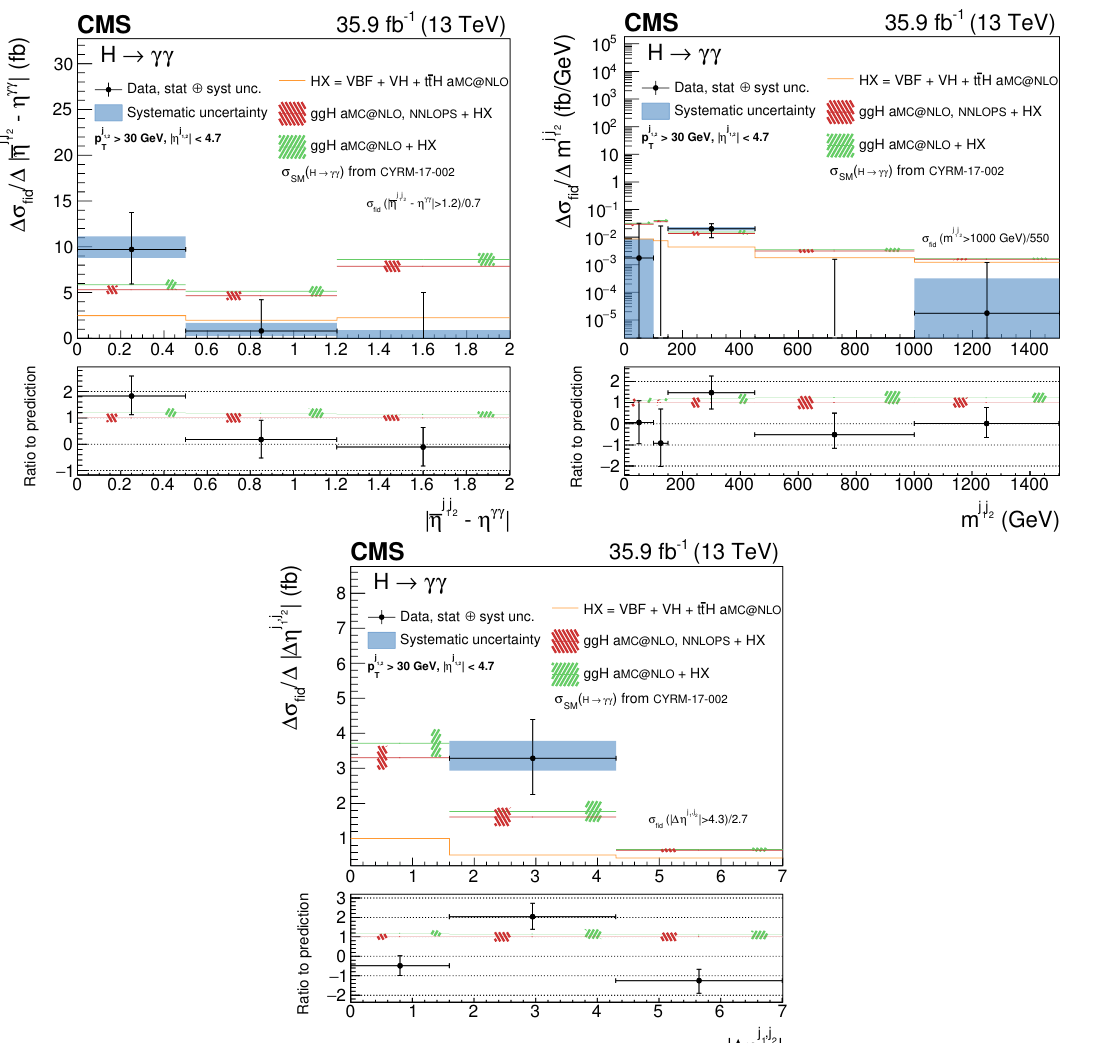
Figure 7 . Measurement of the di(cid:11)erential cross section (black points) as functions of j (cid:17) m j 1 j 2 , and j (cid:1) (cid:17) j 1 ;j 2 j . The error bars indicate 1 standard deviation uncertainty. The systematic component of the uncertainty is shown by the blue band. The measurements are compared to two di(cid:11)erent simulation programs (histograms) with their uncertainties (hatched areas), both normal- ized to the same theoretical predictions from ref. [13]. When the last bin of the distribution is an over(cid:13)ow bin, the normalization of the cross section in that bin is indicated in the (cid:12)gure. enriched region of the phase space, the uncertainties are between 110 and 150%, as shown in (cid:12)gure 8. The double di(cid:11)erential measurement as a function of p (cid:13)(cid:13) in (cid:12)gure 9, allows the extraction of the cross section in 9 bins with uncertainties ranging from (cid:24) 35 to (cid:24) 60%. The measurements as a function of N b in (cid:12)gure 10, have uncertainties, in all bins except the (cid:12)rst, of 200{250%. In the (cid:12)rst bin, which contains the vast majority of the selected events, the uncertainties are comparable to the uncertainty in the inclusive cross section measurement. The results are found to be in agreement with the SM predictions within the